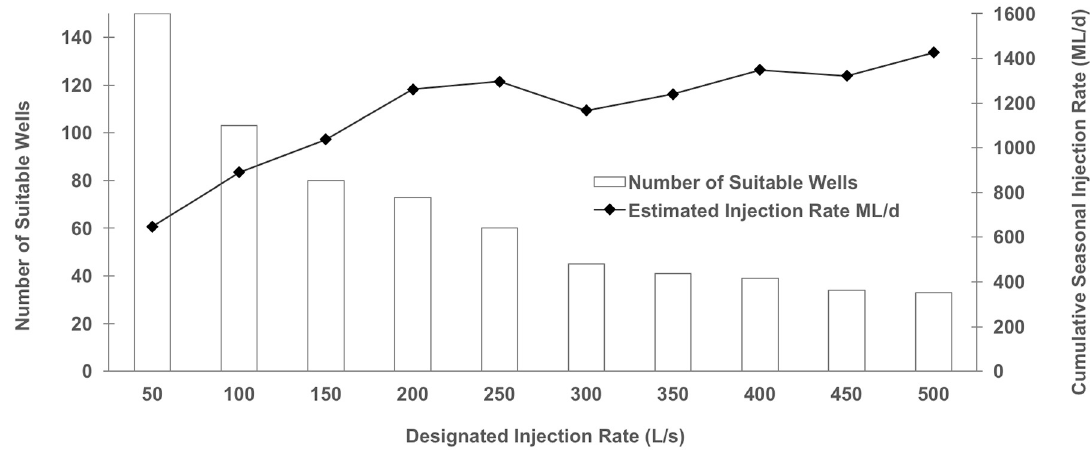
Figure 9. Number of suitable water wells obtained from the water well suitability method and cumulative seasonal storage based on a range of designated injection rates.